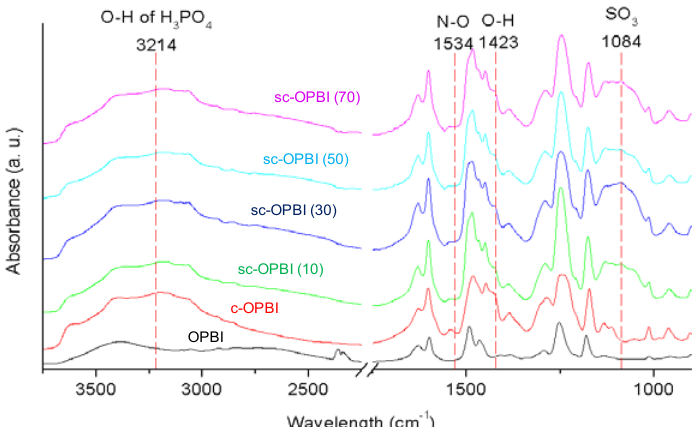
Figure 3. Infrared (IR) spectra of various PBI-based